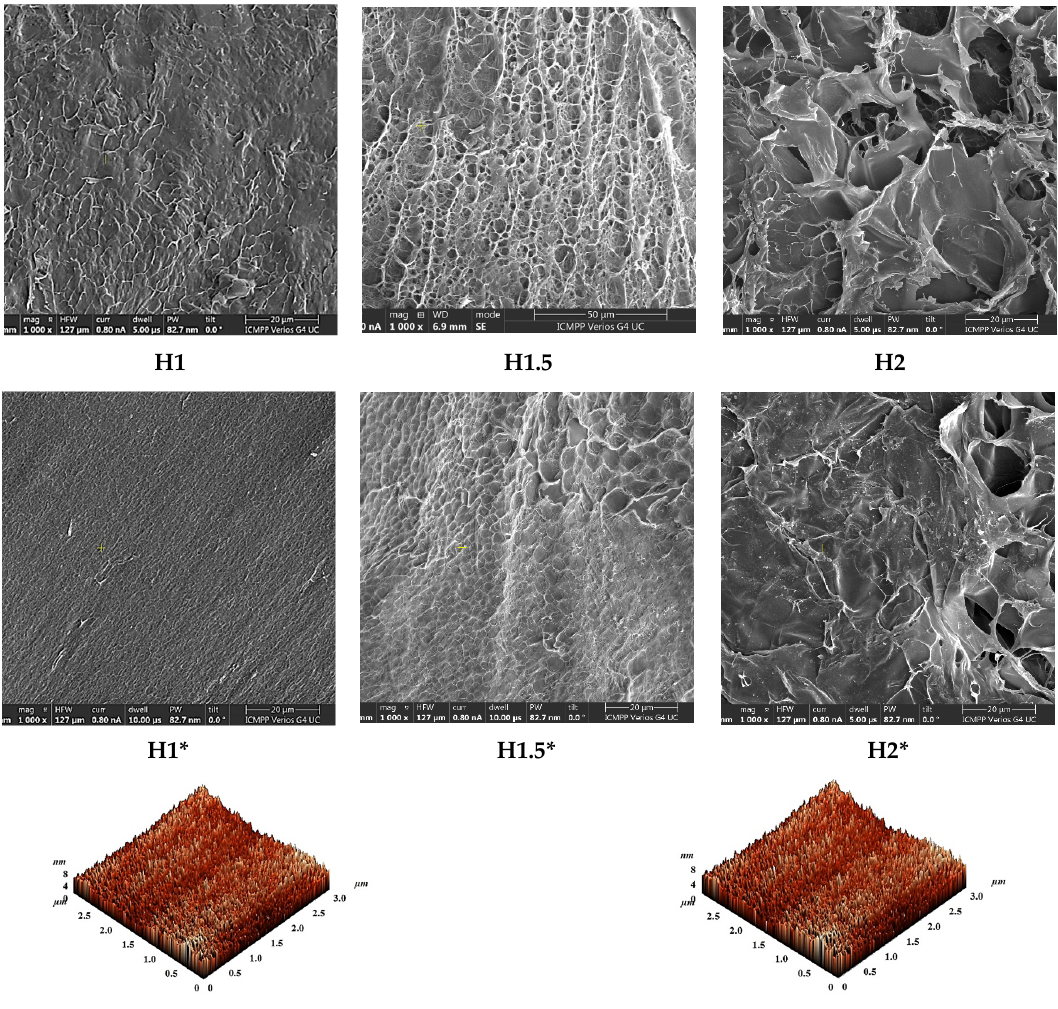
Figure 3. SEM microphotographs of the reference and formulations xerogels and AFM of two representative samples.